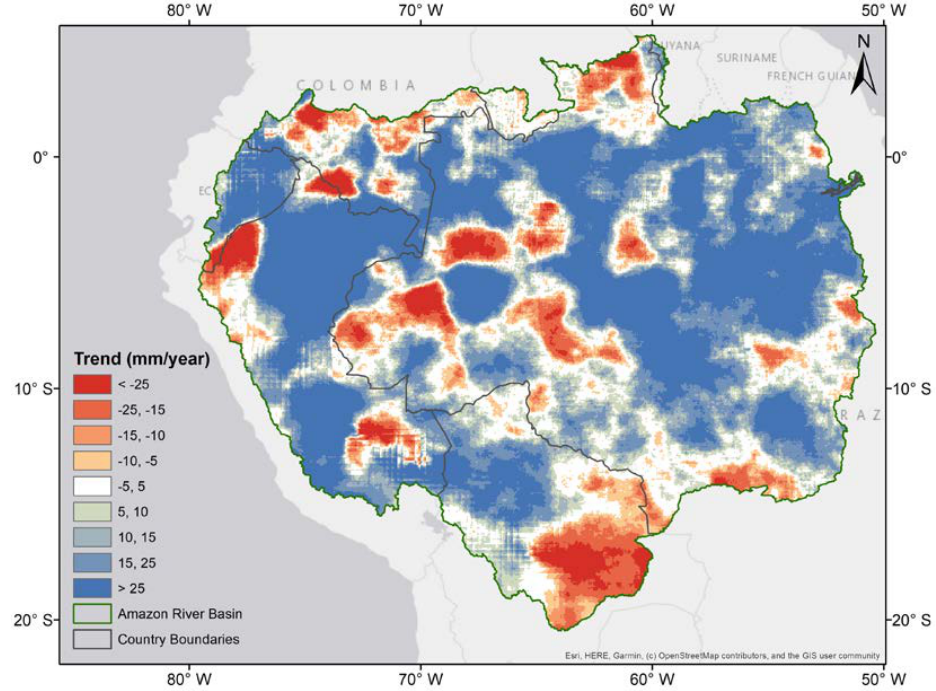
Figure 13. CHIRPS precipitation trends from 2003 to 2013 in the Amazon Basin.